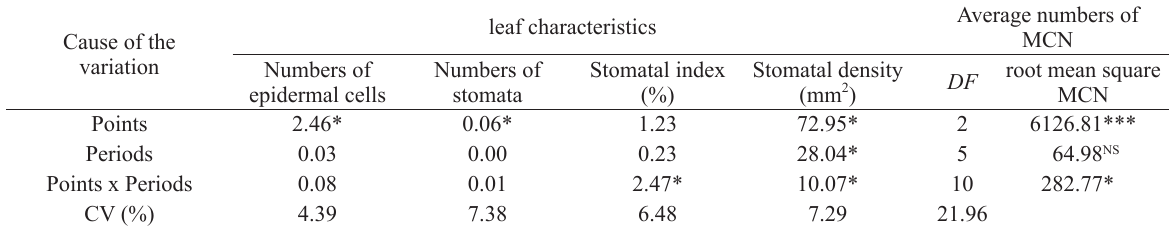
Variance analysis data of the leaf characteristics analyzed and average numbers of micronuclei (MCN), considering the sampling points and the collection periods and observed in Tradescantia pallida